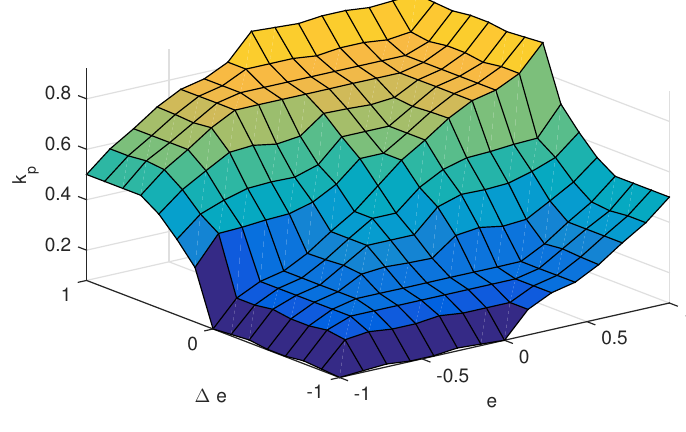
Figure 9. Fuzzy surface for K p gain.